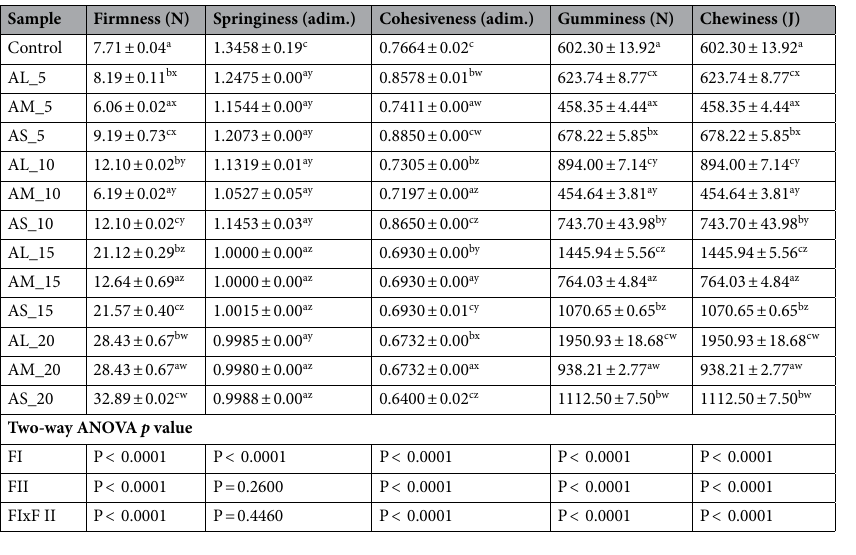
Table 2. Textural parameters of bread samples with different amaranth flour particle sizes, large (L), medium (M) and small (S) and wheat flour replacement levels (5, 10, 15 and 20). FI: amaranth flour particle size; FII: amaranth flour replacement level; mean followed by the same alphabets in each column are not significantly different ( p > 0.05), the first (a-c) and second (x-w) letter in each column indicates particle size and replacement level,